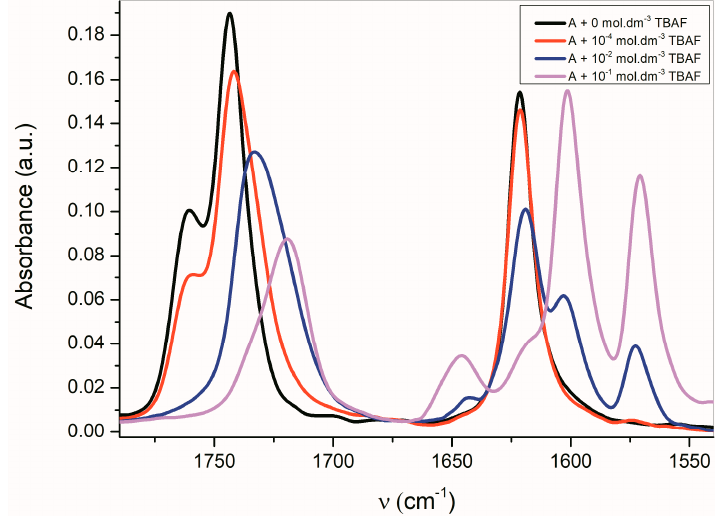
Figure 5. Change of FTIR spectra of A (1 × 10 − 2 mol·dm − 3 ) in CHCl 3 depending on the TBAF concentration.